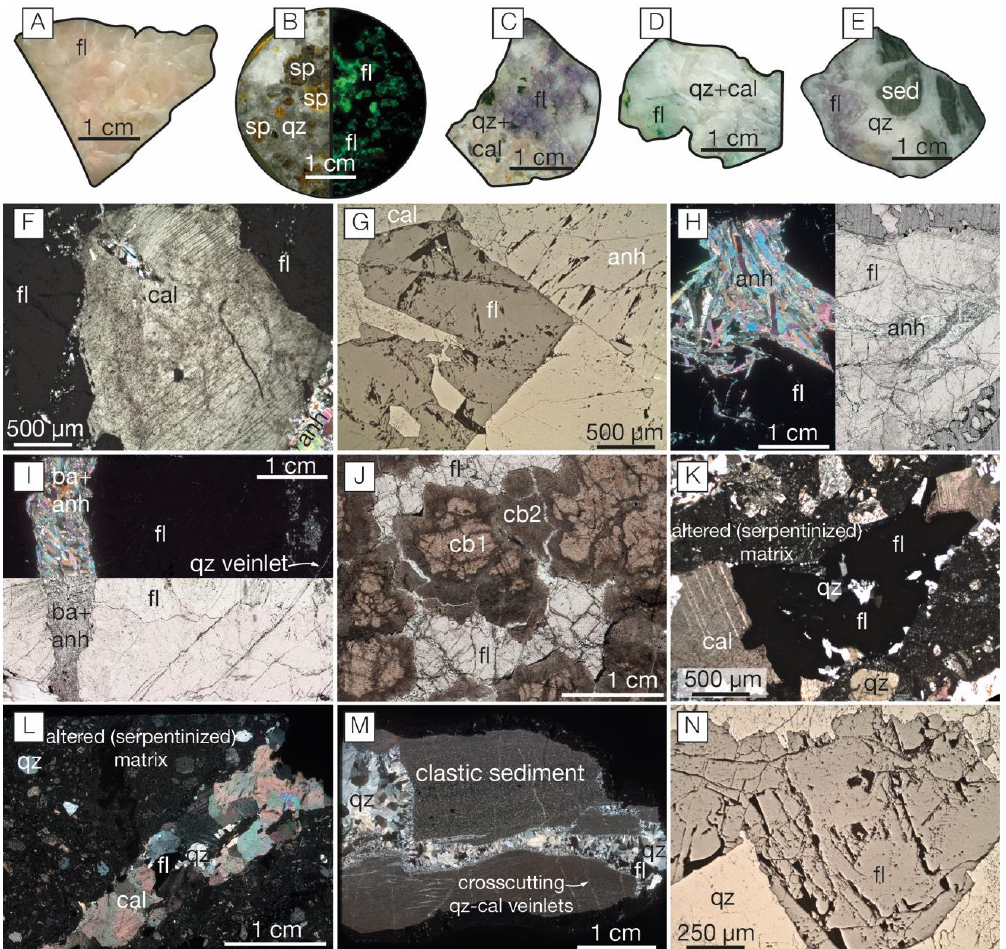
Figure 2. ( A ): Pinkish fluorite from ABB Well E. ( B ): Polished mount with fluorite surrounding sphalerite in hydrothermal quartz-calcite-sulphide vein from the Main Dolomite (Staßfurt Carbonate, Ca2) carbonate, LSB Well F. The right half of the polished mount shows the fluorescence of the fluorite (photographed after UV light exposure). ( C ): Pale violet fluorite in quartz-calcite vein from FCB Sohle 3 (see also K). Dark angular crystals are large chalcopyrite grains. ( D ): Greenish to colourless fluorite in quartz-calcite vein from FCB Sohle 4. (see also L) ( E ): Lavender fluorite in quartz vein (Biwender Vein) from the Harz Mountains. Dark areas are siliciclastic sediment clasts. (see also M). ( F ): Fluorite (dark) associated with calcite and anhydrite in a hydrothermal vein from ABB WELL A. (crossed polars, transmitted light) ( G ): Large hypidiomorphic fluorite (dark grey) associated with calcite and anhydrite. Quartz (bottom left) often occurs as idiomorphic inclusions in fluorite. (reflected light). ( H ): Massive fluorite mineralization with large clusters of hydrothermal anhydrite from ABB Well C. (transmitted light, crossed and plain polars). ( I ): Massive fluorite mineralization with late barite-anhydrite vein and small quartz veinlets from ABB Well D. (transmitted light, crossed and plain polars). ( J ): Fluorite associated with carbonate that displays recrystallizing textures is intergrown with organic material (dolomitic Ca2 carbonate) from LSB Well F. (transmitted light) ( K ): Quartz-calcite-fluorite vein in ignimbrite from FCB Sohle 3. (transmitted light, crossed polars). ( L ): Quartz-calcite-fluorite vein in ignimbrite from FCB Sohle 4. (transmitted light, crossed polars) ( M ): Quartz-fluorite vein (Biwender Vein) in fine-grained clastic sedimentary host rock. Quartz shows characteristic syntaxial candle growth texture. A set of later quartz veinlets is cross-cutting the quartz-fluorite vein. (transmitted light, crossed polars). ( N ): Hypidiomorphic fluorite (dark grey) in quartz-fluorite vein (Biwender Vein) from the Harz Mountains. (reflected light)—qz: quartz, fl: fluorite, cal: calcite, cb: carbonate mineral, anh: anhydrite, ba: barite, sp: sphalerite, sed: clastic sediment clast.